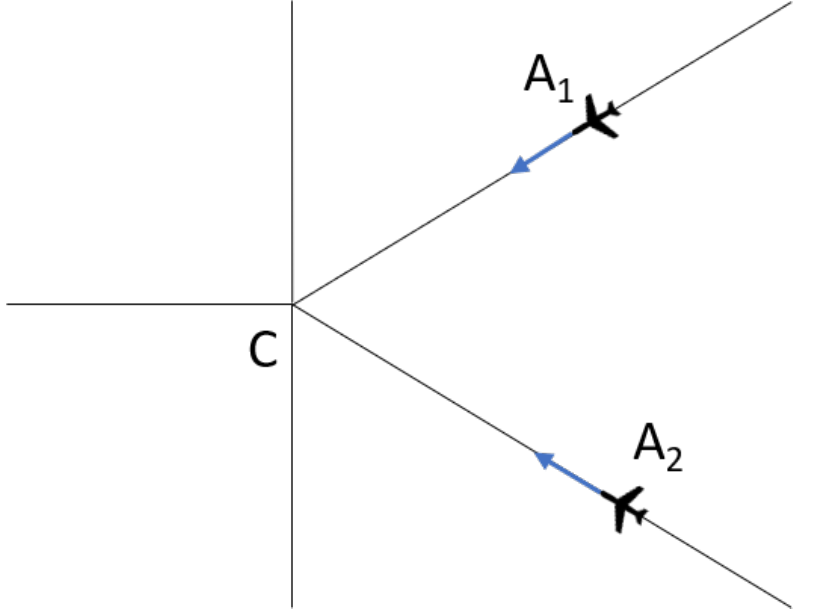
Figure 11. Conflict scenario involving two Aircrafts, A 1 and A 2